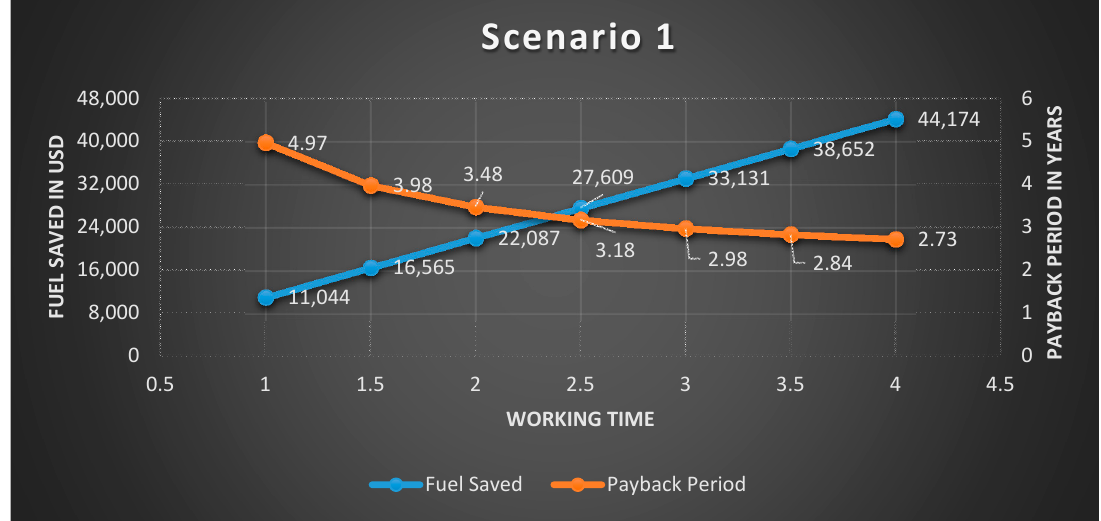
Figure 9. Fuel savings and payback time with operating times for 10%L + 20%L loads.